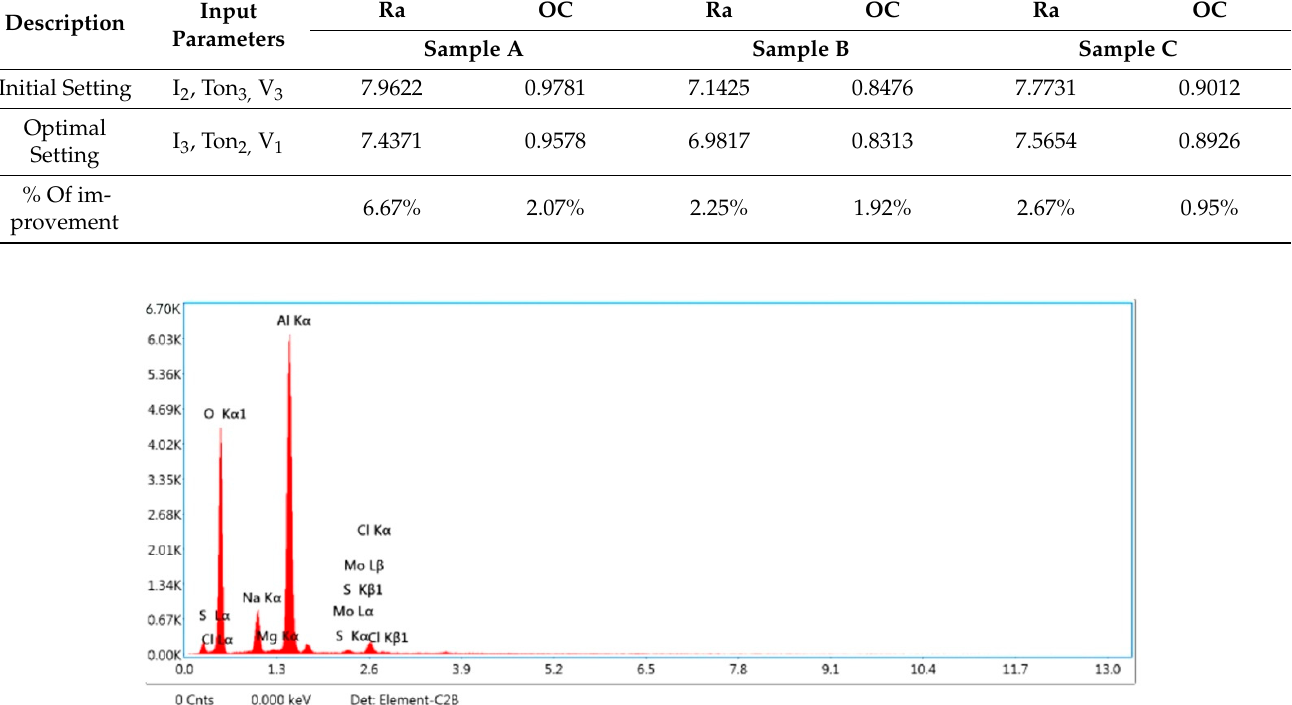
Figure 2. SEM image of machined surface at ( a ) 100X and ( b ) 800X at initial condition.